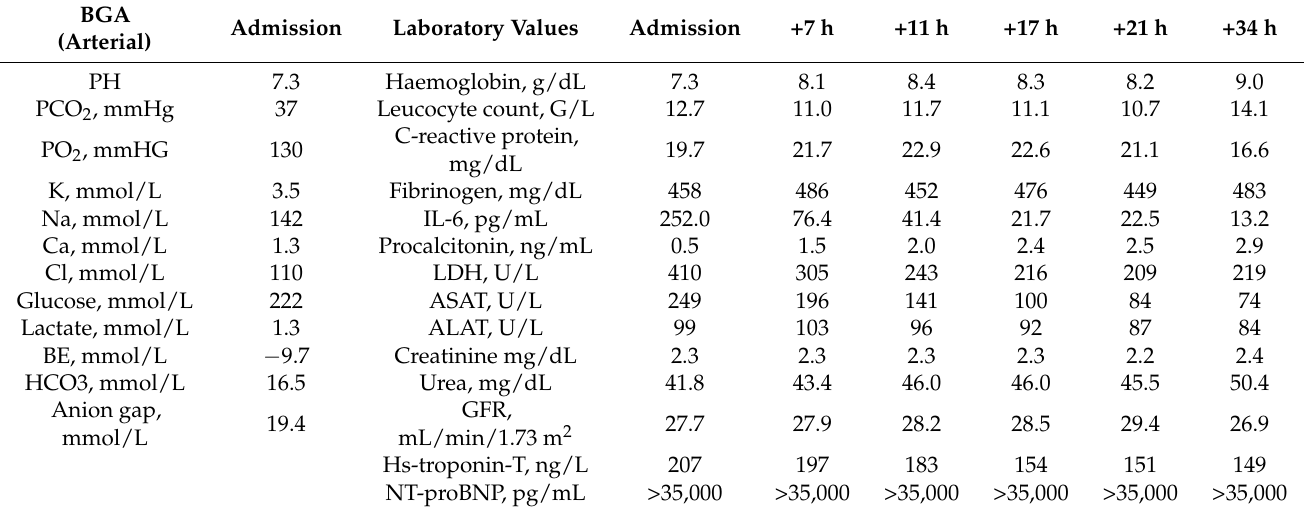
Table 1. Selected laboratory values and respective dynamics throughout the